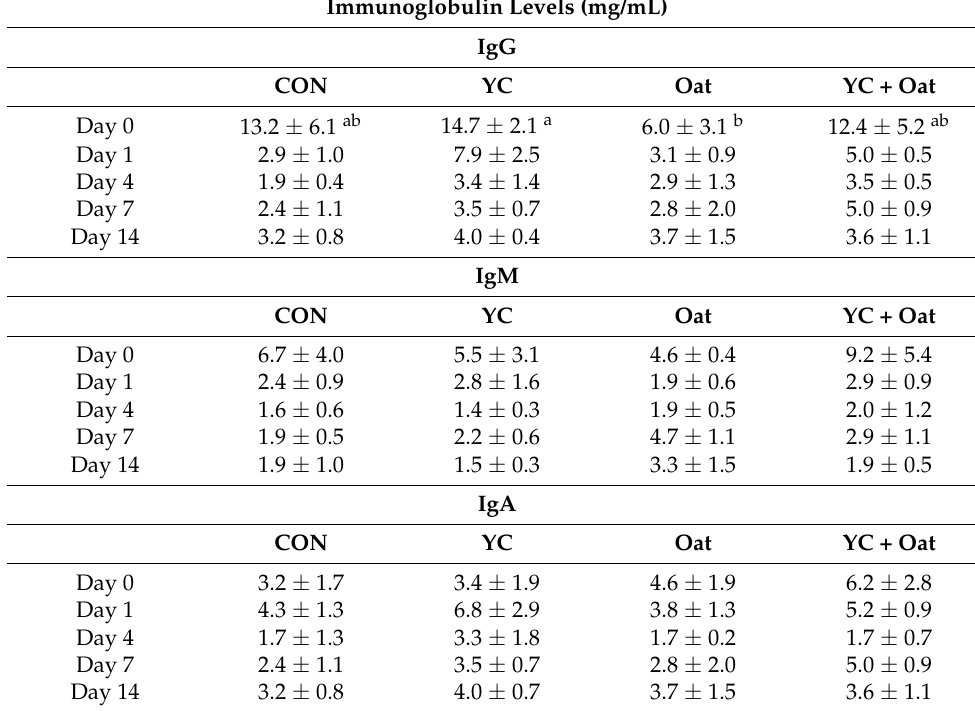
Table 4. Immunoglobulin (Ig) Levels in Milk across Lactation.